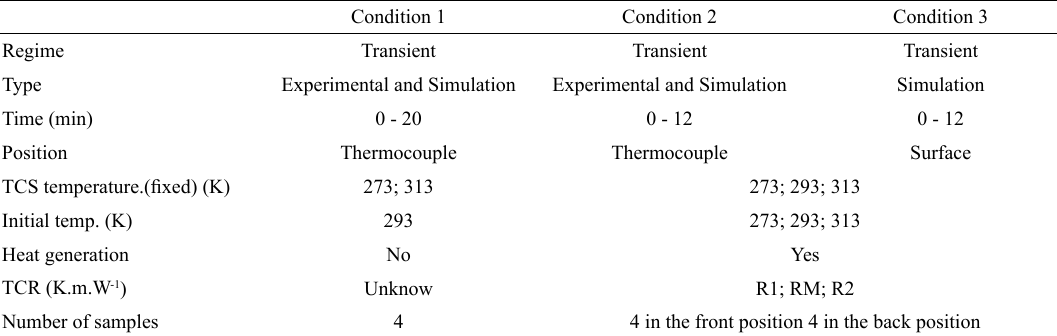
Figure 1. (a) Experimental Setup, (b) Detail of sample holder (dimensions in mm), (c) Three-dimensional model used for simulation Table 1. boundary conditions for